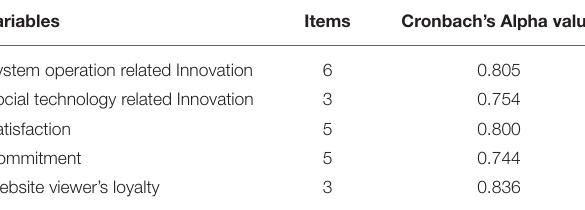
TABLE 1 | Reliability analysis of all variables.